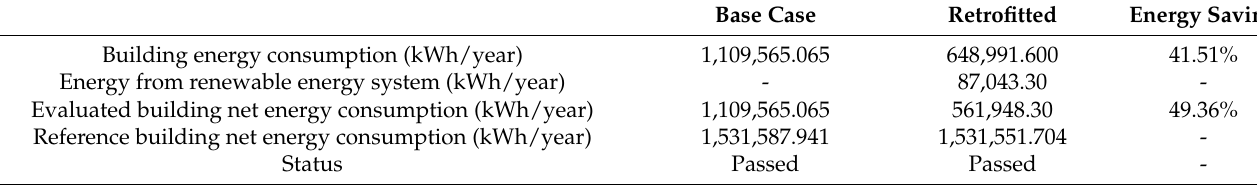
Table 16. Total energy consumption provided by the BEC software.